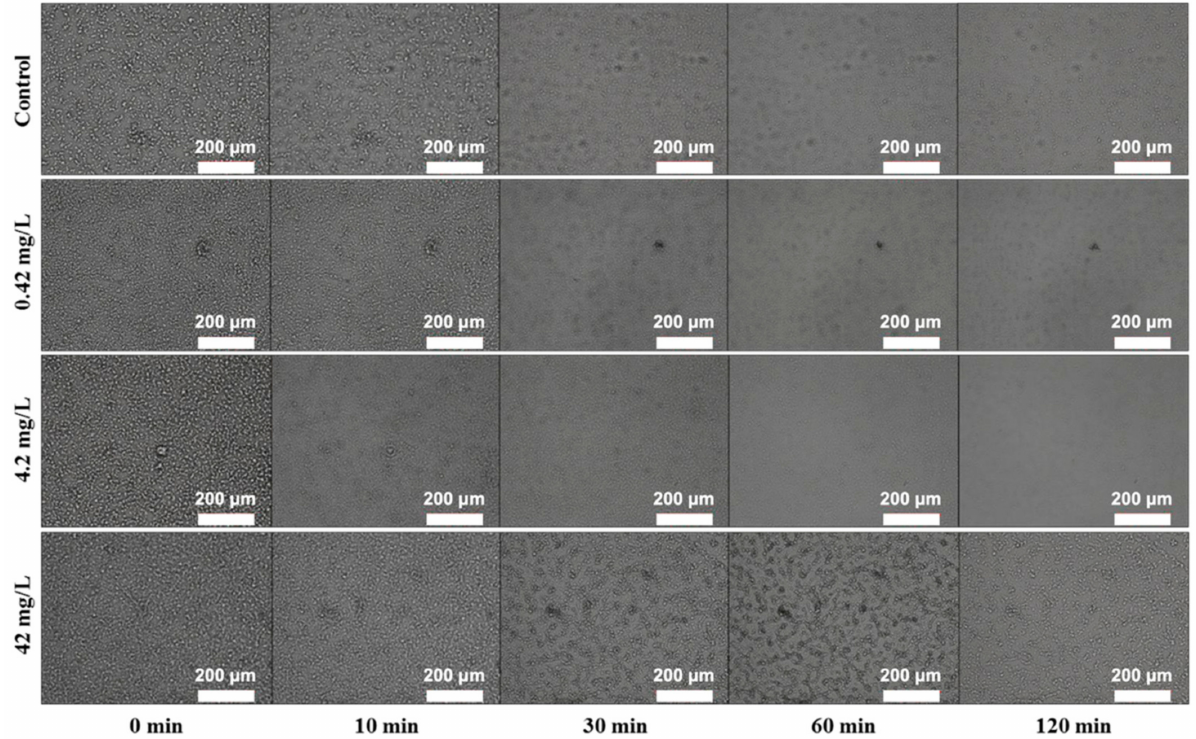
Figure 4. Microscopy images of biofilm formed on the glass slide surface treated with different LAE concentrations and time. Other experimental conditions: all the LAE treatment times were identical (60 min) and followed by PBS dosing (60 min). The shear rates in all tests were equal to 3.42 s − 1